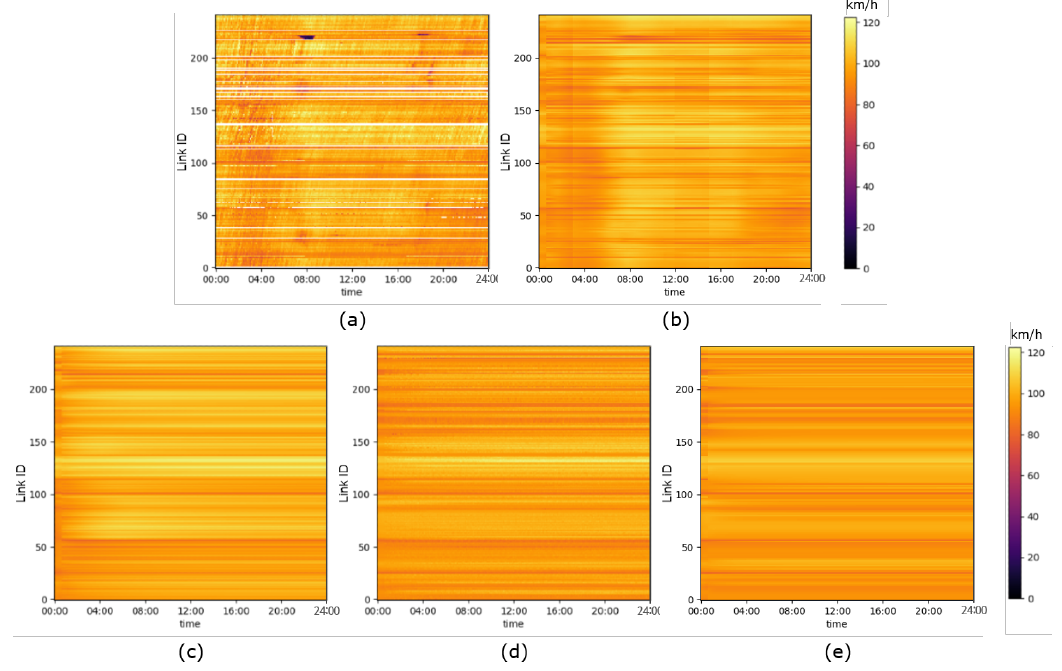
Figure 9. Speed figure of ( a ) real data, ( b ) TW-DNN, ( c ) CNN-only, ( d ) k -nn, and ( e ) ARIMA for Case